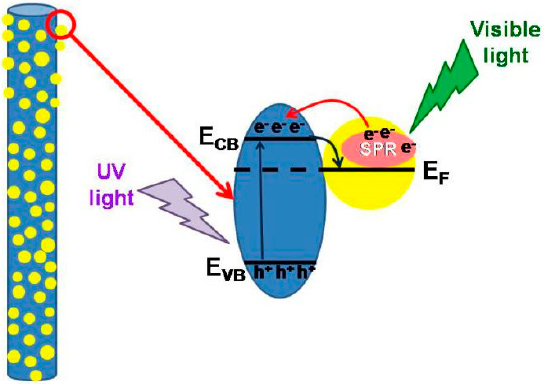
Figure 8. Excitation mechanism under UV light and charge-transfer mechanisms between Au NPs and TiO 2 NFs under visible-light excitation.